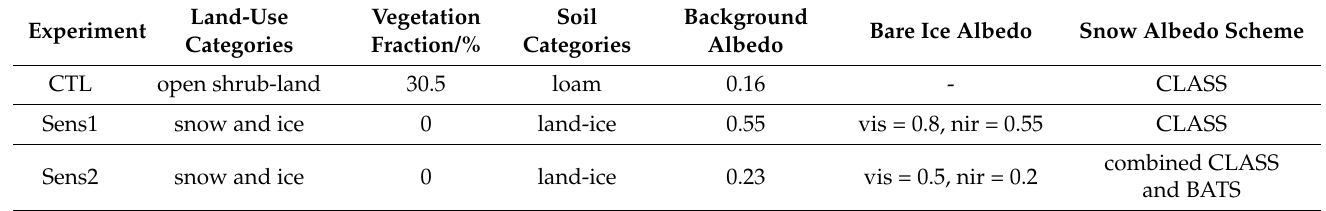
Table 2. Initial surface conditions in the ablation zone of the glacier and snow albedo schemes that were used in our experiments (vis = visible, nir = near